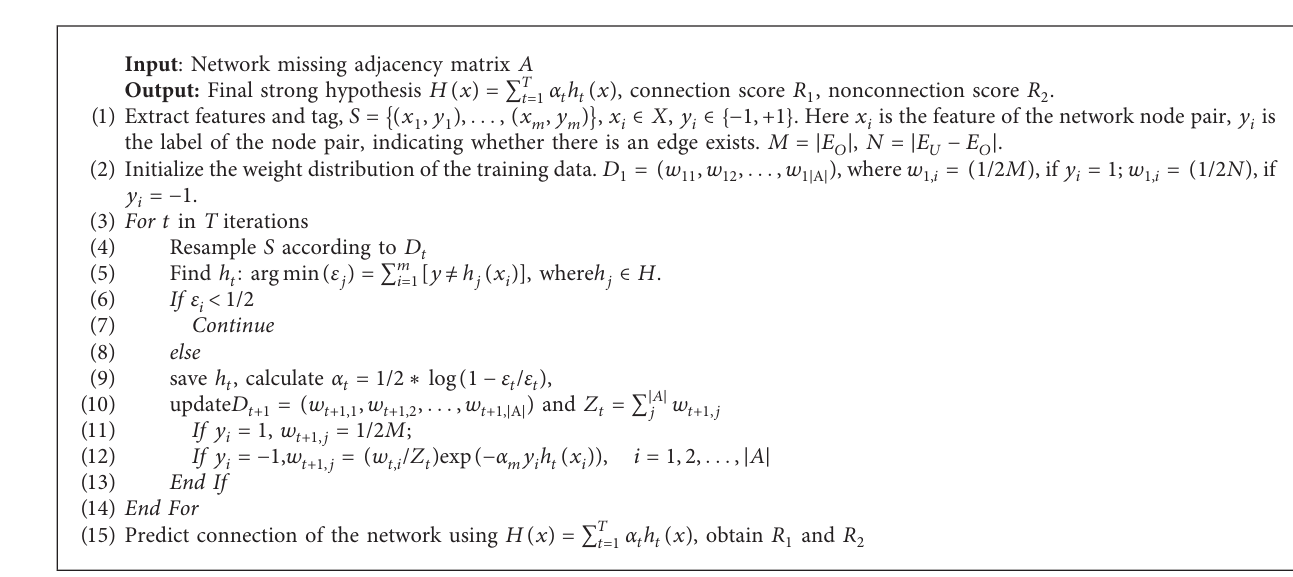
A LGORITHM 1: Process flow of the Linkboost link prediction